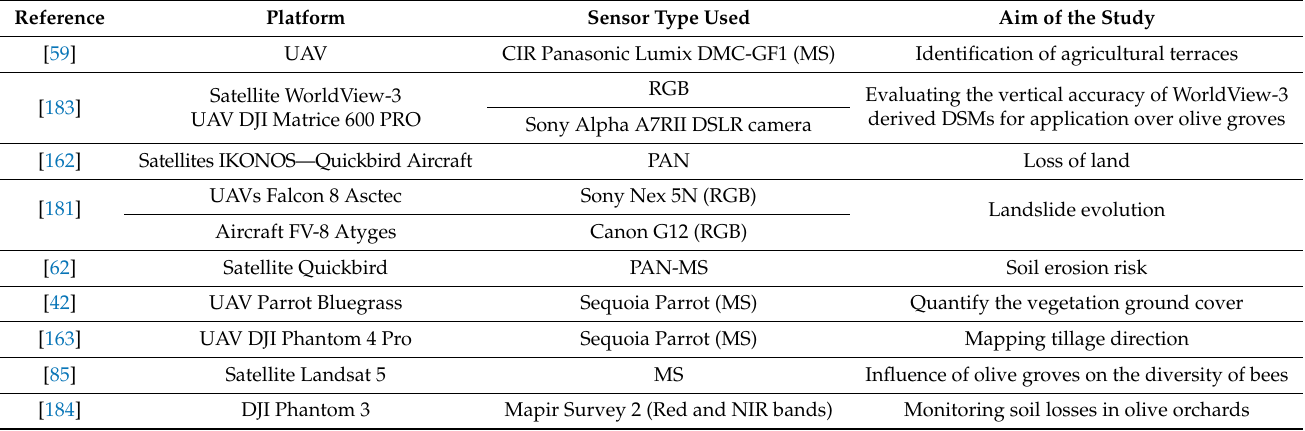
Table 3. References dealing with the preservation of the olive landscape and soil